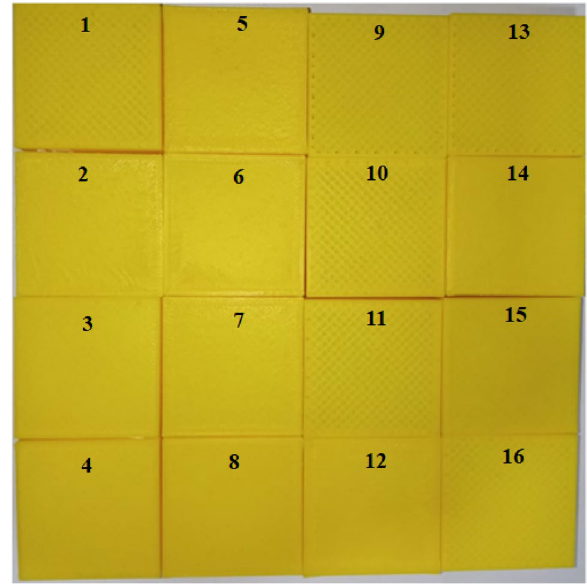
Figure 3. Fabricated FFF specimens.